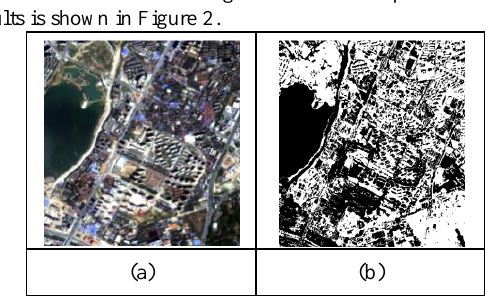
Figure 2. Example of vegetation extraction result (a) original image; (b) vegetation extraction result